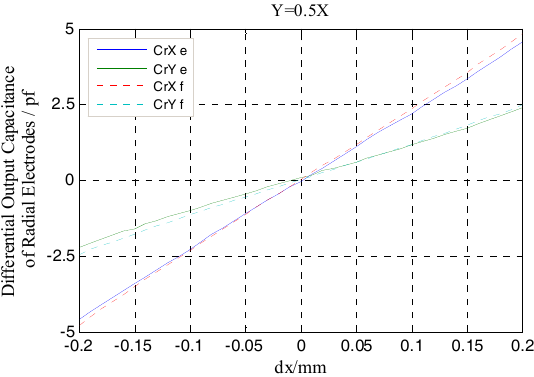
Figure 23. Comparison of experimental and simulation values of the radial differential output capacitance.